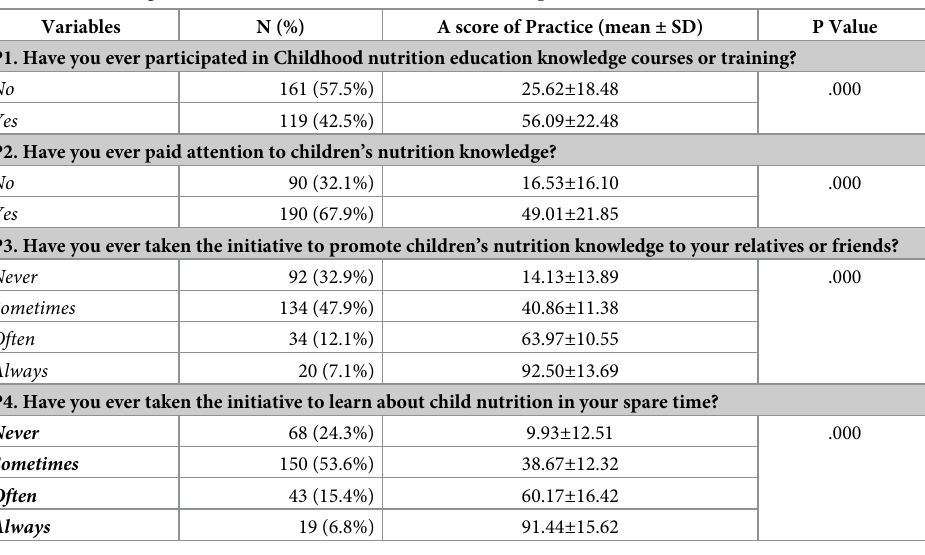
Data were collected from 280 school teachers distributed in nine different districts throughout Bangladesh. Values were presented as number and percentage (N and %) or mean and standard deviation ( mean ± SD).